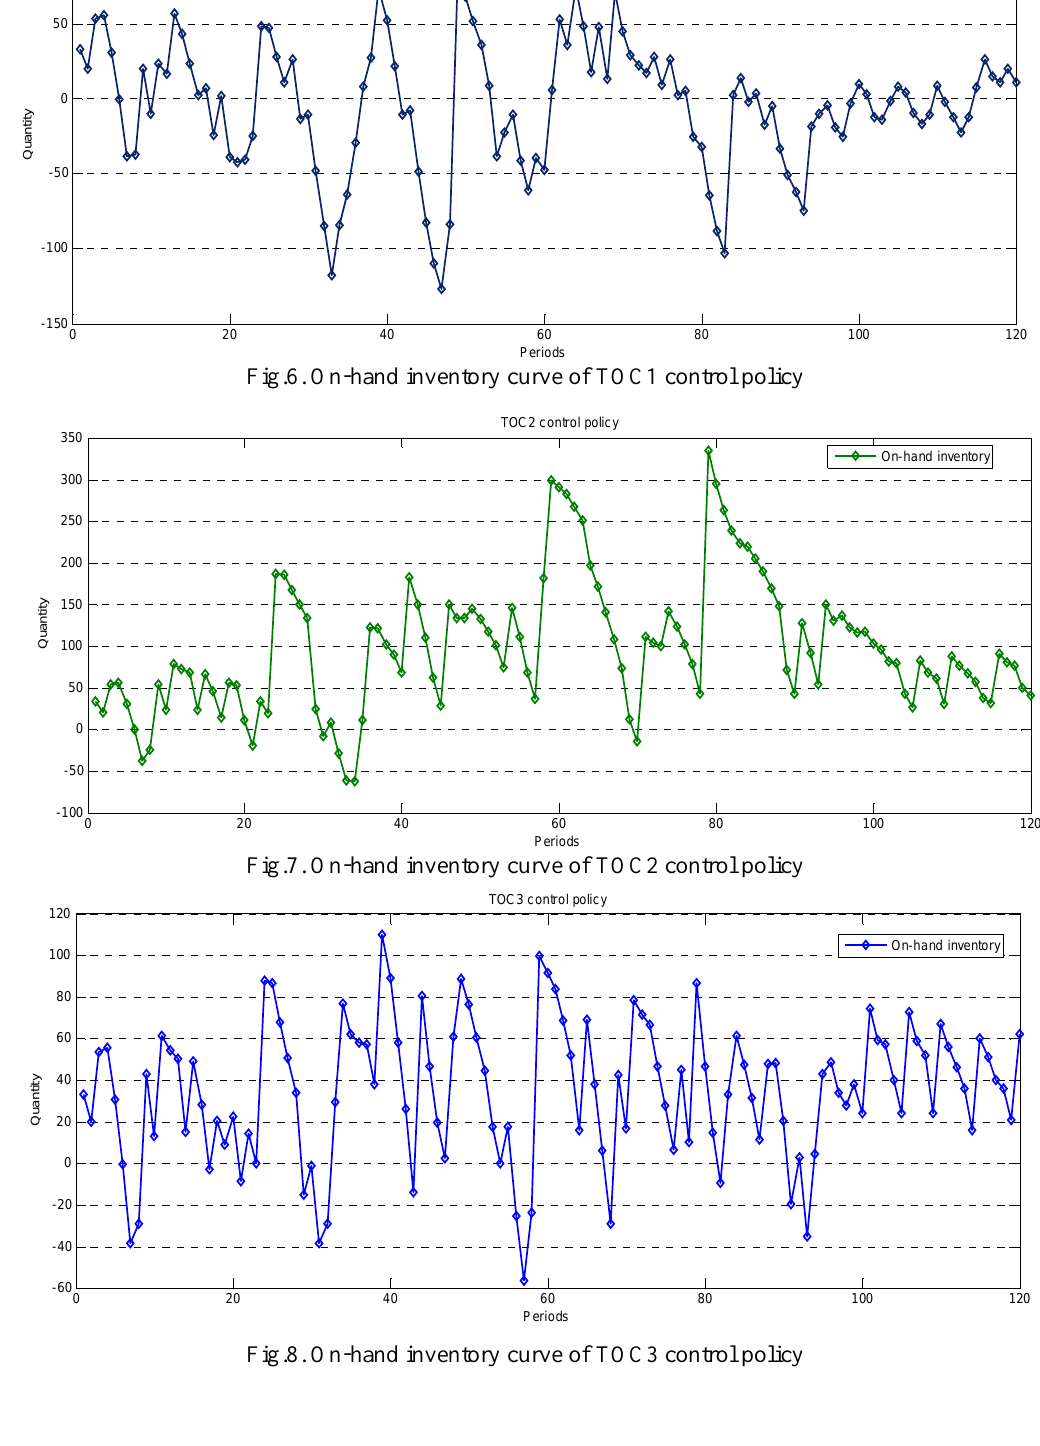
Fig.8. On-hand inventory curve of TOC3 control